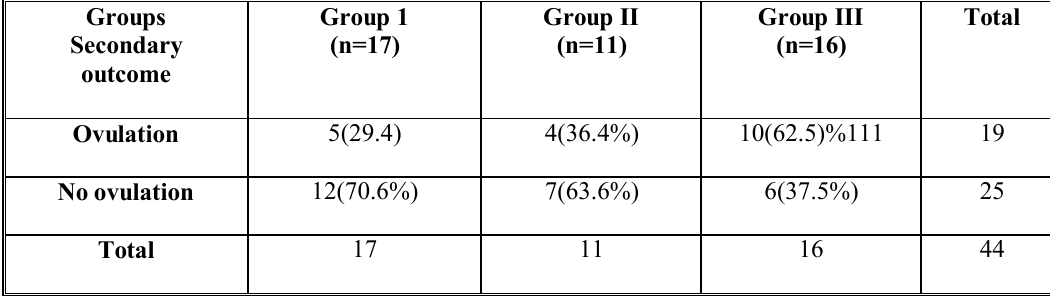
Table (5): Ovulation rate in PCOS patients for treatment with insulin sensitizing agents.